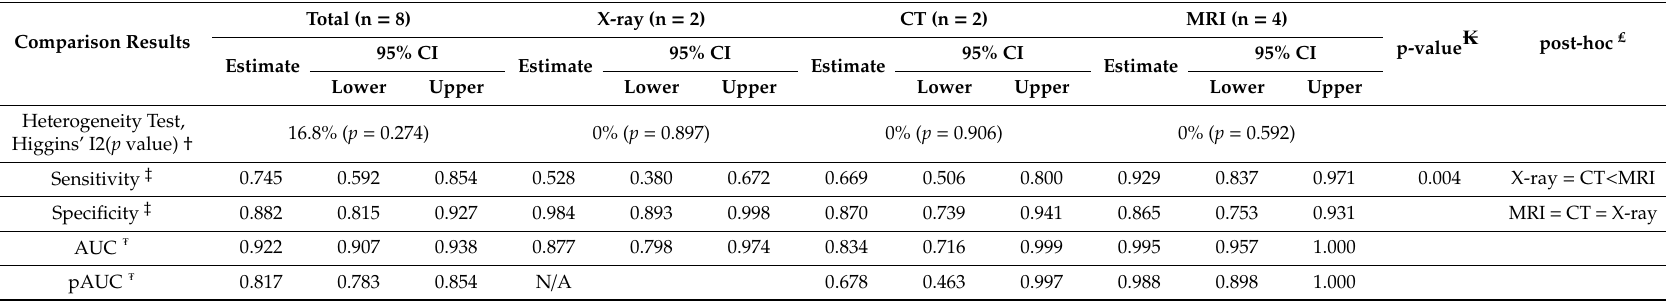
Table 4. Comparison results for each diagnostic test; CI, confidential interval; AUC, area under the curve; pAUC, partial area under the curve.